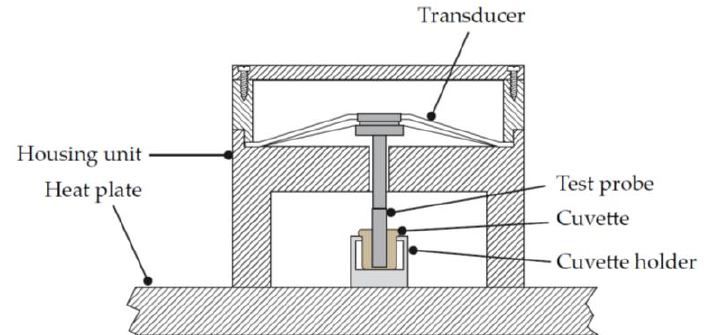
Figure 7. Schematic of the Sonoclot ® system. The sample to be tested is placed in a cuvette within the housing unit. The linear test probe is then lowered into the cuvette and is in contact with the sample to be tested. An electric signal through the transducer produces a linear oscillatory motion of the test probe whilst a heat plate warms the sample to be tested through the cuvette holder. Adapted from US Patent 5,138,872 [16].